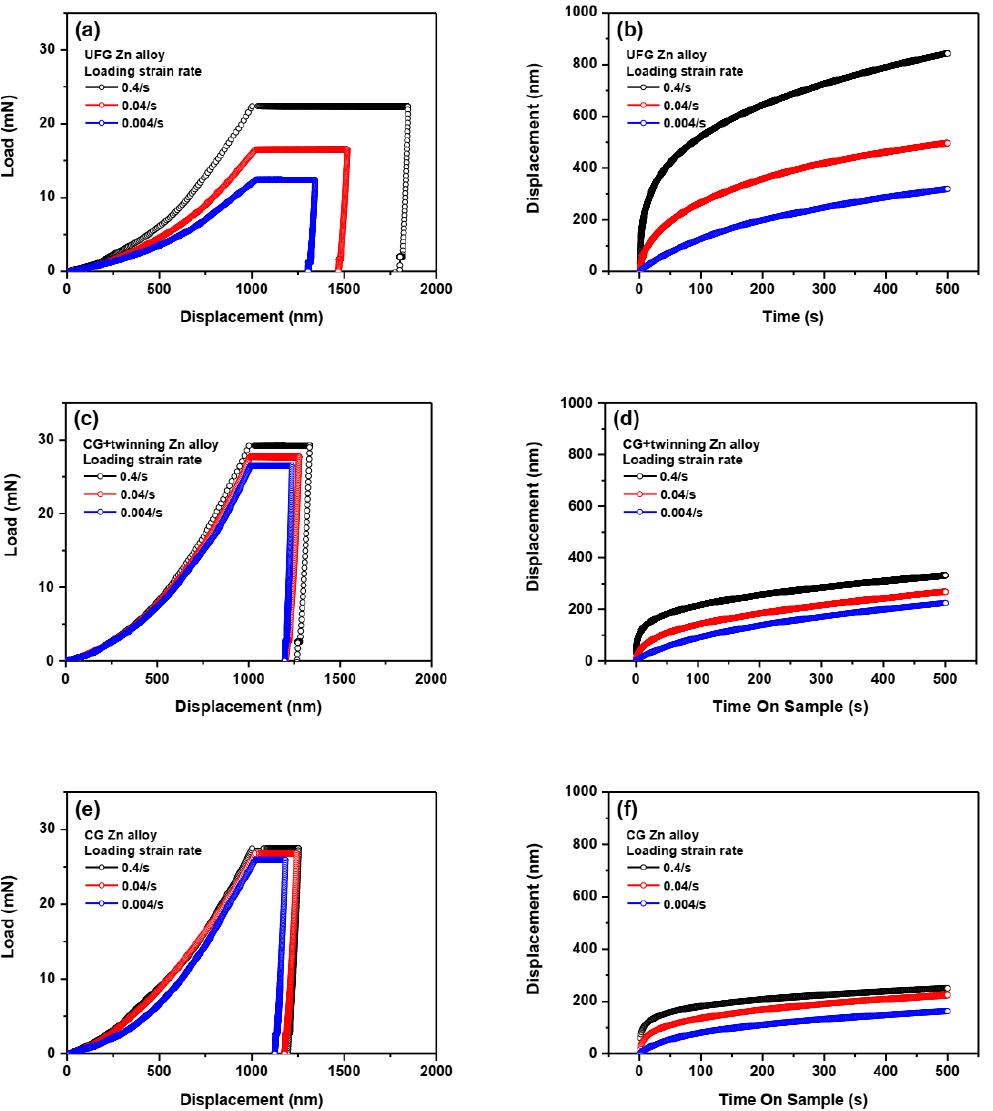
Figure 6. ( a , c , e ) Load–displacement and ( b , d , f ) creep displacement–time curves obtained at